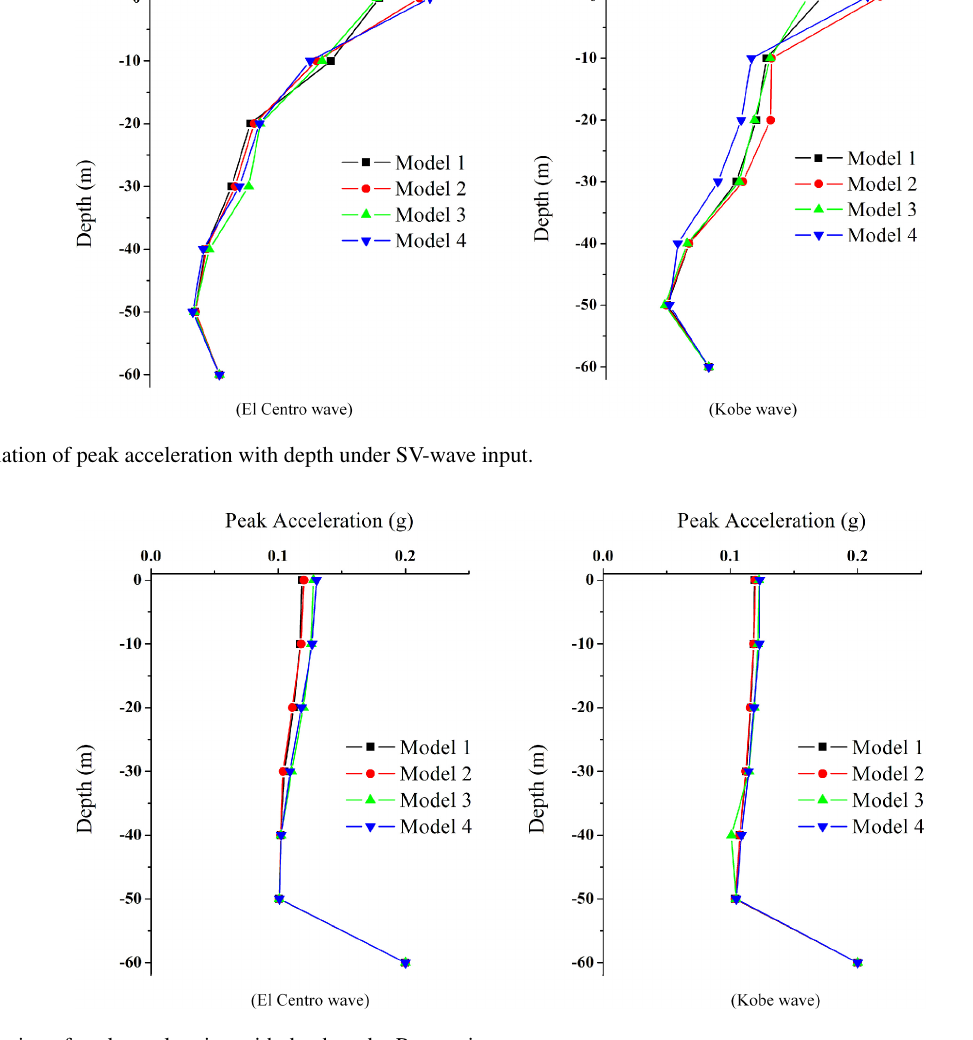
Figure 8. Variation of peak acceleration with depth under P-wave